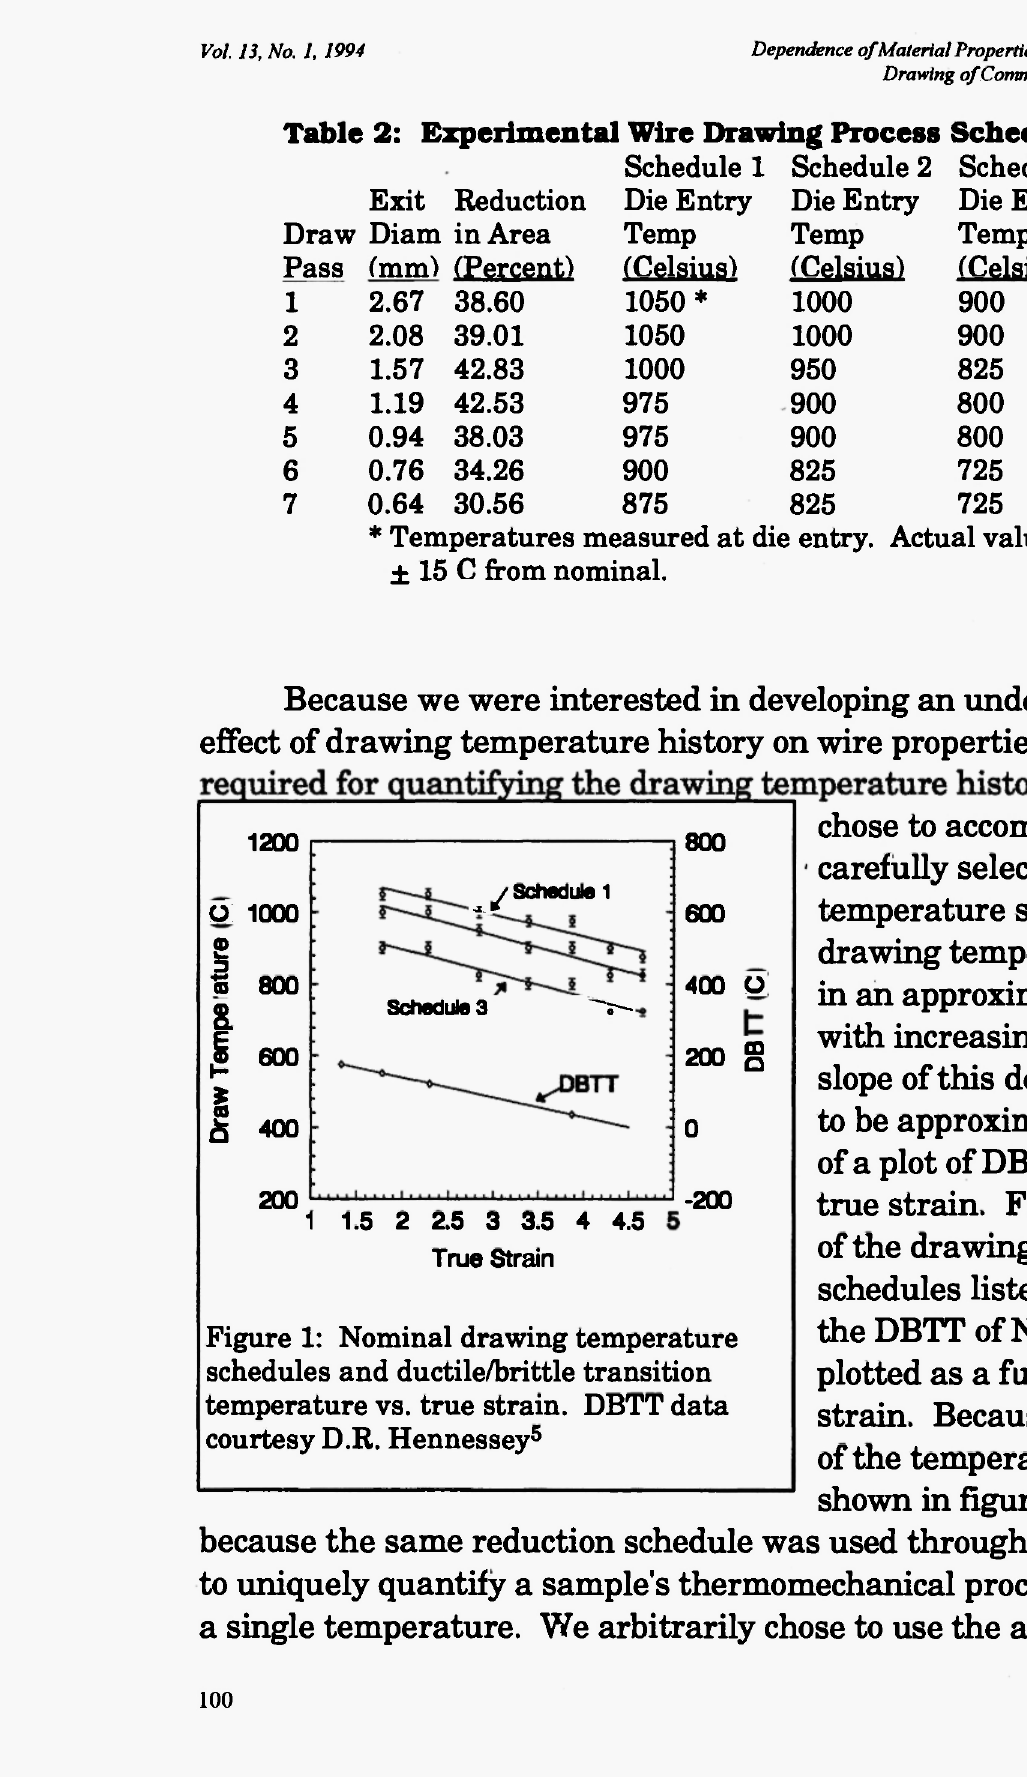
Table 2: Experimental Wire Drawing Process Schedules Schedule 1 Schedule 2 Schedule 3